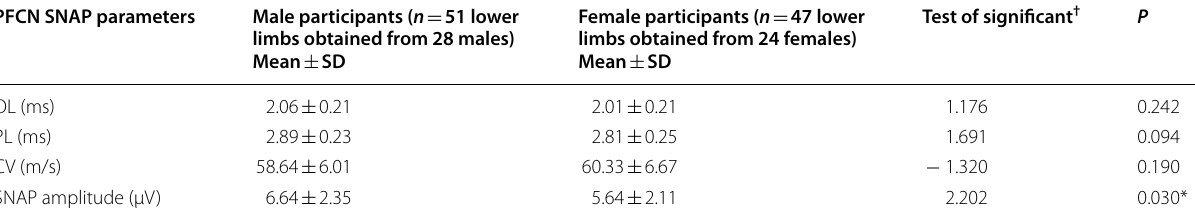
Table 4 Comparison between the two genders regarding posterior femoral cutaneous nerve sensory nerve action potential parameters